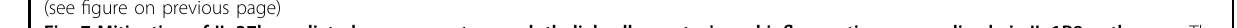
Fig. 7 Mitigation of IL-37b-mediated coronary artery endothelial cell apoptosis and in fl ammation was realized via IL-1R8 pathway. a The expression of IL-1R8 were detected in the KD mouse model after IL-37b treatment ( n = 6). b Effects of silencing of IL-1R8 on coronary arteritis were observed by H&E staining. Magni fi cation: ×200. Scale bar = 100 μ m. c – e The endothelial expression of VCAM-1, macrophage marker F4/80, and neutrophil marker was examined after IL-1R8 gene silencing using IHC staining. AOI were indicated with a red arrow. Scale bar = 100 μ m. Right: The histograms respectively exhibited the percentage of VCAM-1, F4/80, and neutrophil marker-positive areas. Signi fi cance: * P < 0.05 vs. the PBS group, # P < 0.05 vs. the CAWS group, and & P < 0.05 vs. the CAWS + IL-37b group. f DNA fragmentation was examined using TUNEL staining. Scale bar = 100 μ m. Below: Percentage of TUNEL-positive cells was shown in the histogram. Signi fi cance: * P < 0.05 vs. the PBS group, # P < 0.05 vs. the CAWS group, and & P < 0.05 vs. the CAWS + IL-37b group. g , h BAX/Bcl-2 ratio was analyzed by western blot analysis. i The mRNA expression levels of IL-6, TNF- α , and IL-1 β were determined after silencing of IL-1R8. j – l Effects of IL-1R8 silencing on the phosphorylation level of ERK and NF κ B p65 were assessed by western blotting. Signi fi cance: * P < 0.05 vs. the PBS group, # P < 0.05 vs. the CAWS group, and & P < 0.05 vs. the CAWS + IL-37b group. N =